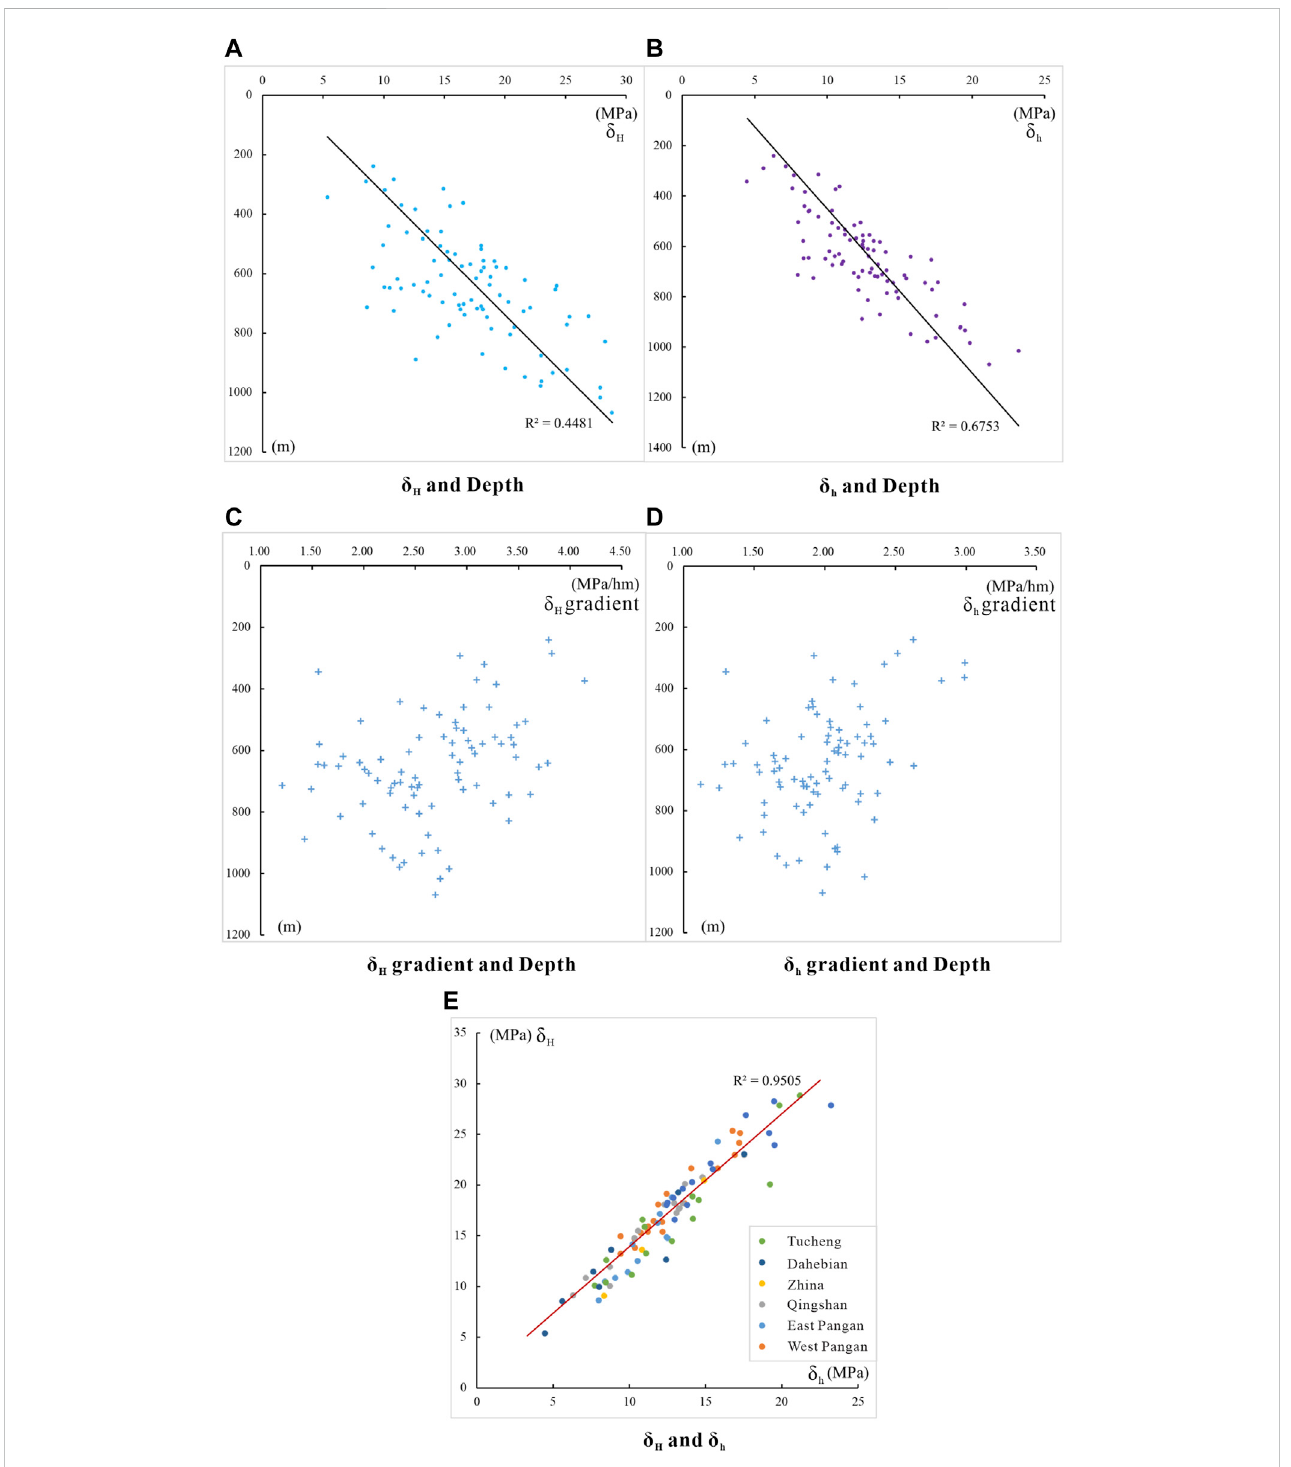
Relationship between δ H and depth (A) , δ h and depth (B) , δ H gradient and depth (C) , δ h gradient and depth (D) , δ H and δ h (E)